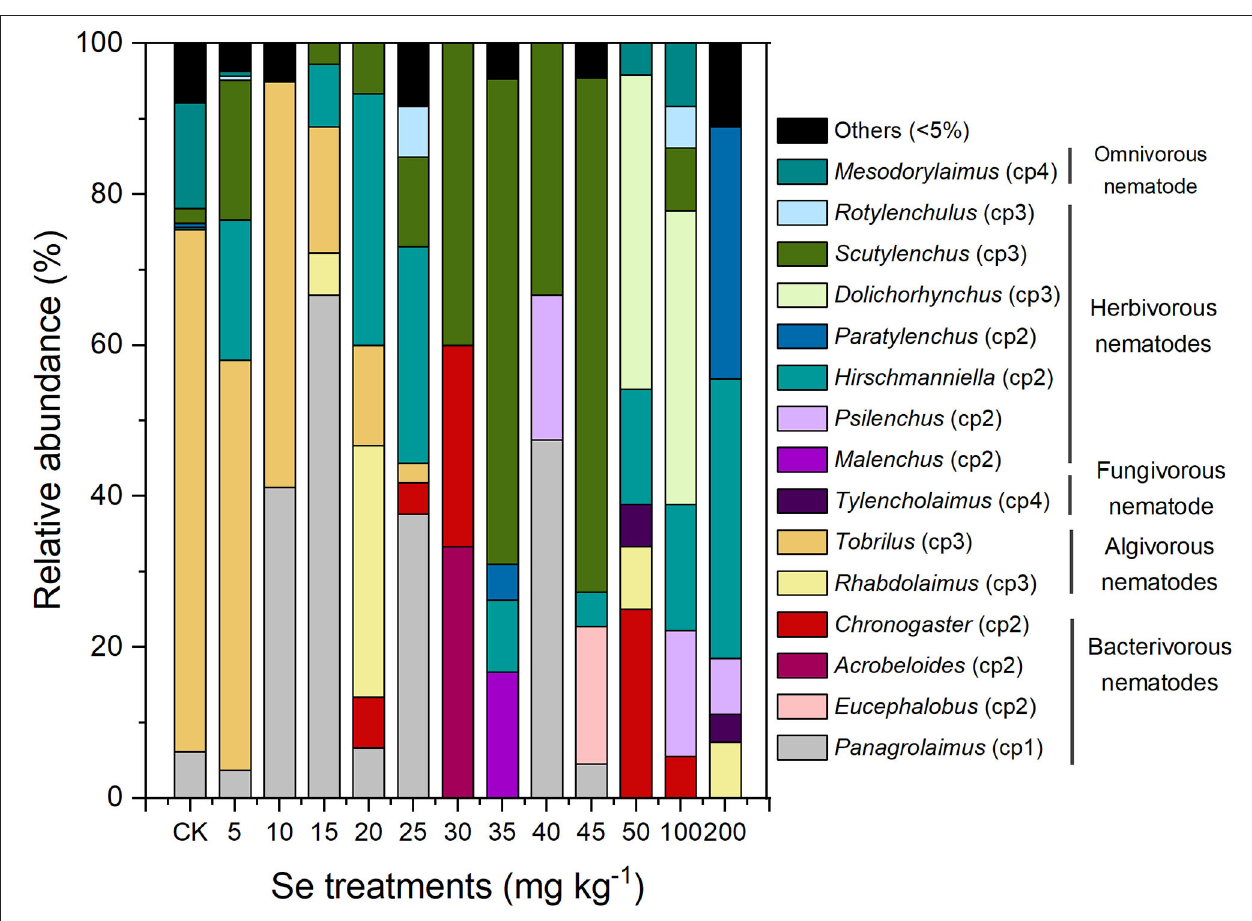
FIGURE 4 | Genus composition of the nematodes in soil under different Se treatments.